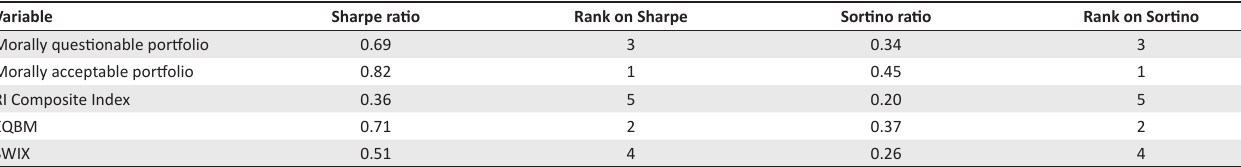
TABLE 4: Risk-adjusted return measures: July 2004 to April 2019. Variable